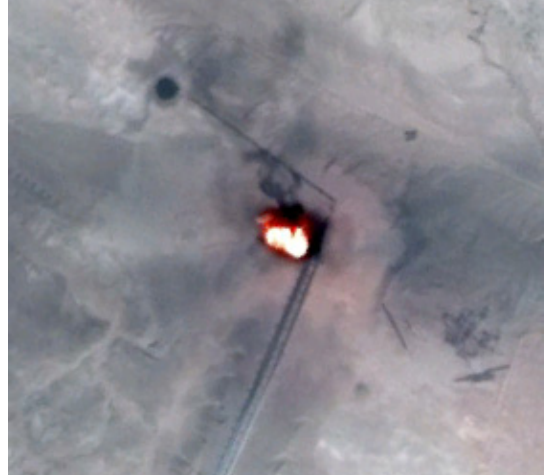
Figure 17. Example of a gas flare in Google Earth base imagery from Digital Globe. The site has a fireball and pipeline structures. In other cases the flare is not active and the flare stack or pipeline is visible.